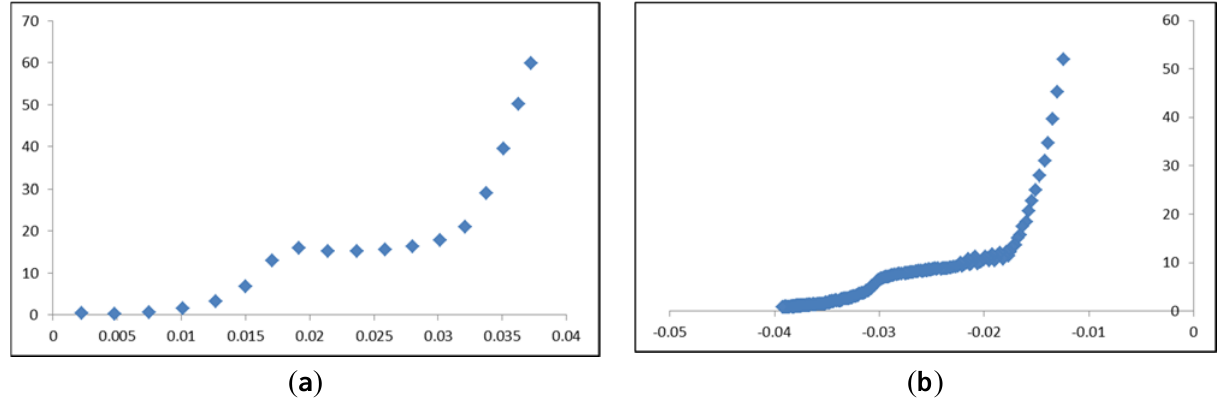
Figure 1. Isotherms of 2.5 grams of Ti-sponge (raw data): ( a ) absorption at 638 °C; plateau pressure = 15 psi (1.03 bar); ( b ) desorption at 638 °C: plateau pressure = 9 psi (0.62 bar). The Y-axis is pressure in psia and the X-axis is bound H 2 in